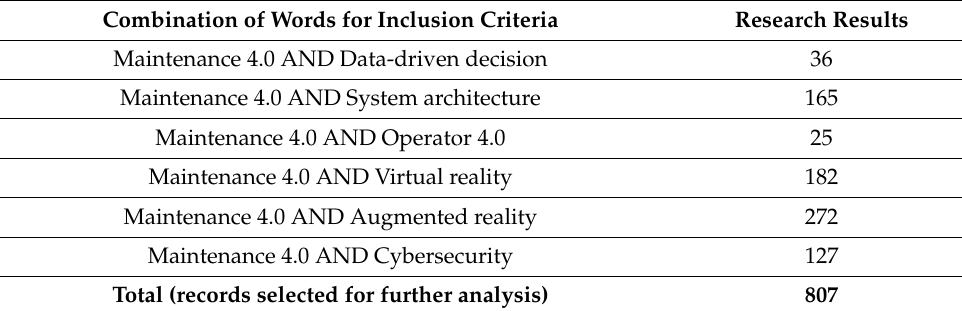
Table 2. A summary of the conducted filtering procedure. Combination of Words for Inclusion